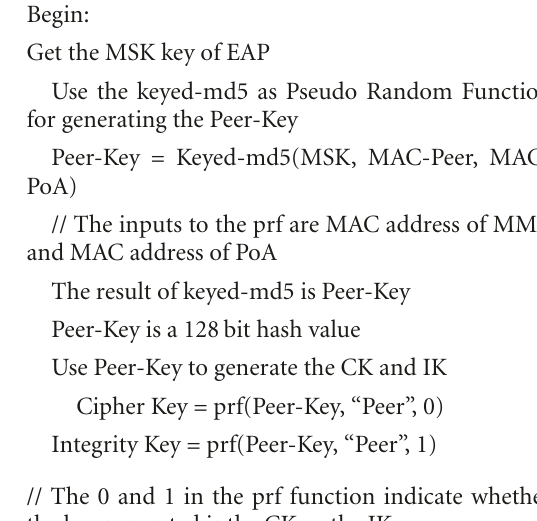
Algorithm 2. Key generation algorithm in